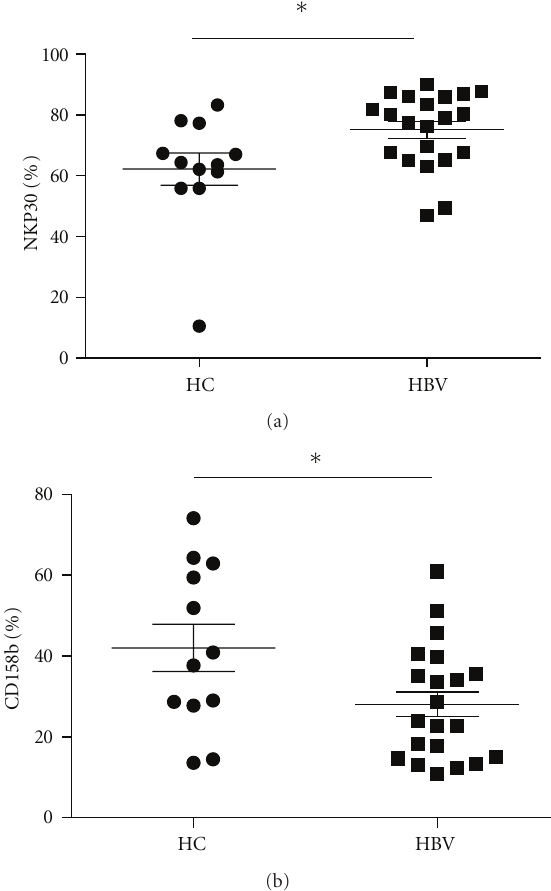
Figure 3: Expression of activating and inhibitory receptors on NK cells in patients with chronic HBV infection. The frequency of activating receptors NKp30 and inhibitory receptors CD158b on NK cells in peripheral blood of 12 healthy controls (HC) and 21 sex and age-matched chronic HBV patients (HBV) (mean ± SEM HBV-DNA 10log 7 . 5 ± 0 . 9 IU/mL, ALT 167 ± 96 IU/mL, 9 e-negative Ag) was determined by FACS analysis. Data show the individual and the mean percentage of expressing cells within the total NK cell population. ∗ P < 0 .